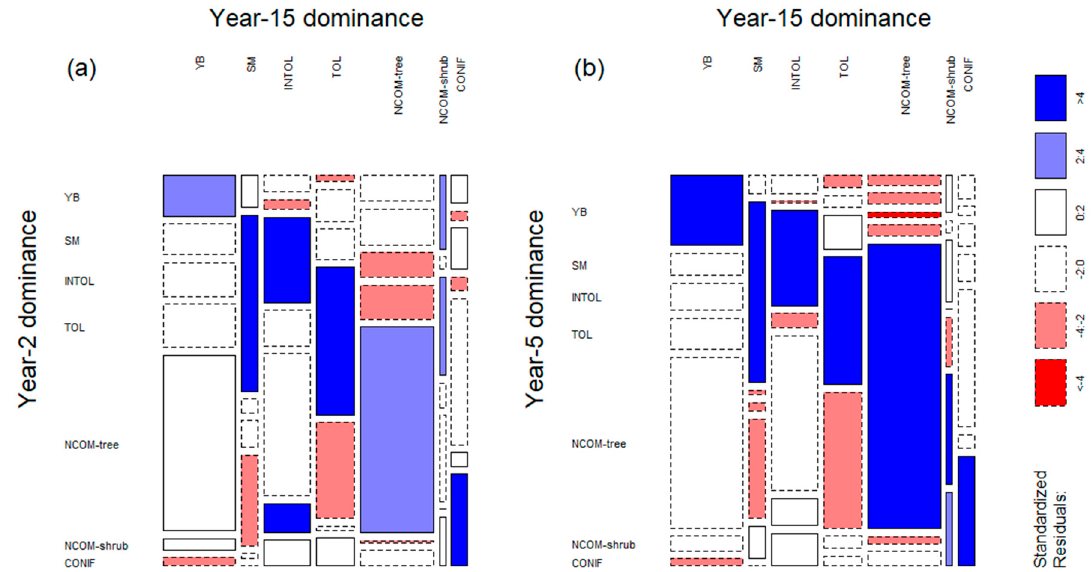
Figure 8. Mosaic plot of the evolution of dominance per quadrat ( a ) between year 2 and year 15 or ( b ) between year 5 and year 15. Levels of the two variables are individual species or species pool. Each cell of the contingency table is represented by a box. A box’s area is the total count in that cell, i.e., the number of quadrats where a given species was dominant in year 2 or 5 (rows) compared with which species was dominant in that same quadrat in year 15 (columns). Box width is the same for all boxes in a column and corresponds to the total count of that column. Box height is the proportion of quadrats in the column that fall into that cell. Blue-colored boxes indicate that there were more quadrats than expected under the null hypothesis (positive residuals), whereas red-colored boxes identify cells where there were fewer quadrats than expected (negative residuals). Standardized residuals were computed as the residual (i.e., observed minus expected value) divided by the square root of the expected value. Residuals above 2 or below − 2 indicate significance at the 0.05 level.